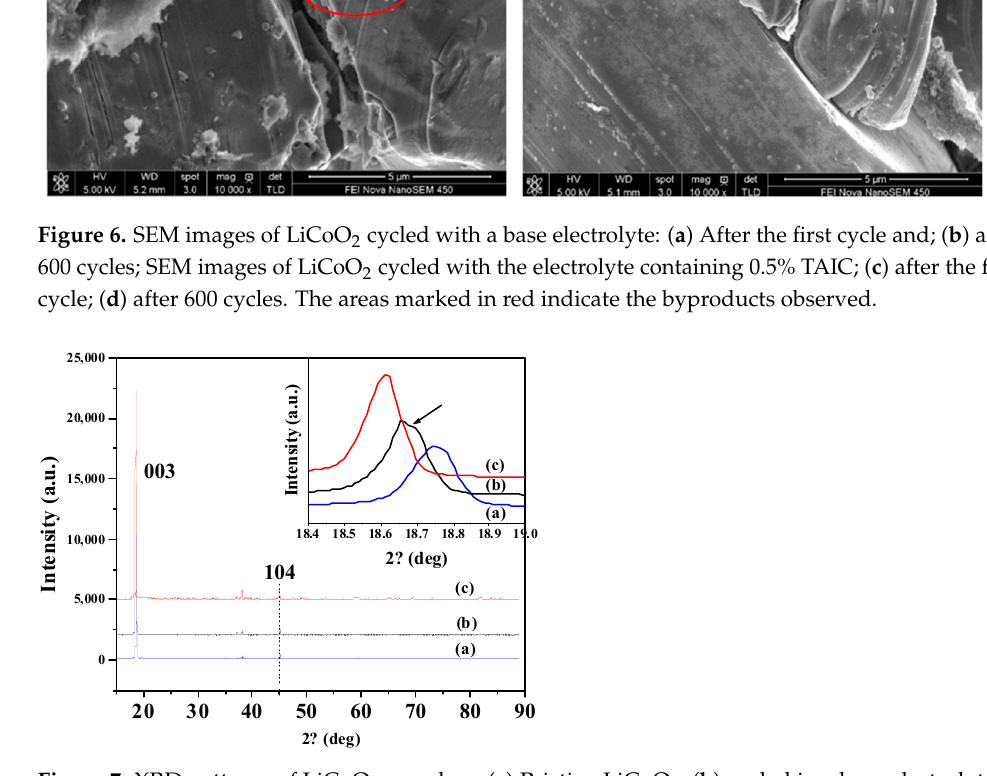
Figure 7. XRD patterns of LiCoO 2 powders: (a) Pristine LiCoO 2 ; (b) cycled in a base electrolyte at 45 45 ◦ C; ( c ) cycled in the electrolyte containing 0.5 wt.% TAIC at 45 ◦ °C; (c) cycled in the electrolyte containing 0.5 wt.% TAIC at 45 °C.